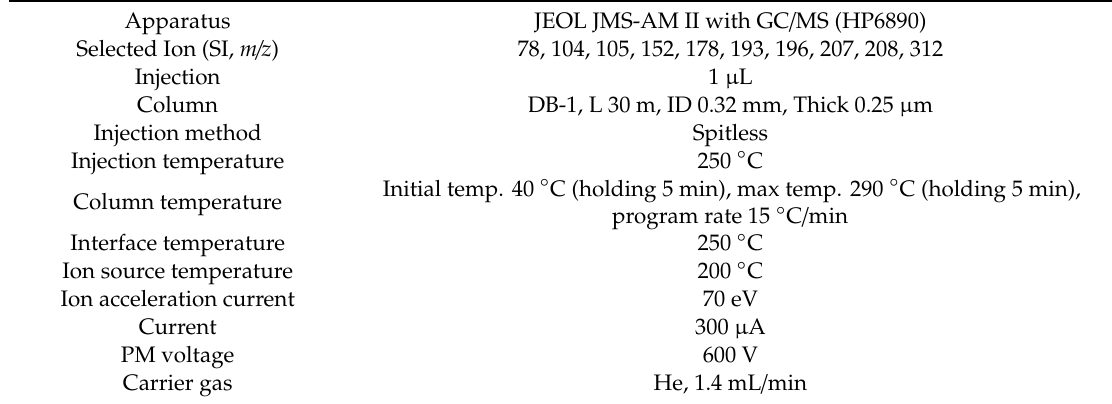
Table 1. Apparatus and operation conditions of GC/MS analysis.